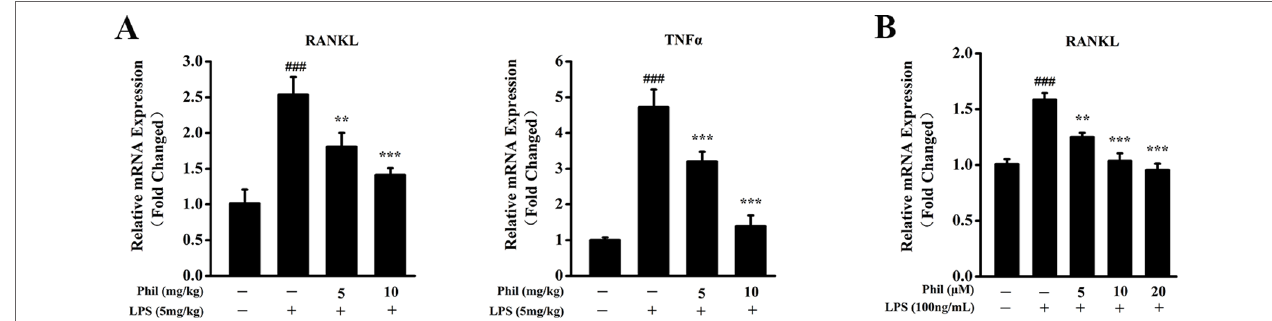
FIGURE 7 | Phil decreases LPS-induced osteoclast-related cytokine expression in calvarias and in cultured osteoblasts. (A) The calvarias from in vivo experiments were homogenized and the expressions of RANKL and TNF α were determined by real-time PCR. The mRNA levels of these two genes were normalized to GAPDH (n = 3). ### P < 0.001 relative to the sham group; ** P < 0.01 and *** P < 0.001 relative to the vehicle group. (B) The hFOB 1.19 cells were treated with LPS (100 ng/ ml) and different doses of Phil (0, 5, 10, and 20 µM) for 24 h. The mRNA level of RANKL was determined by real-time PCR and normalized to β -actin (n =